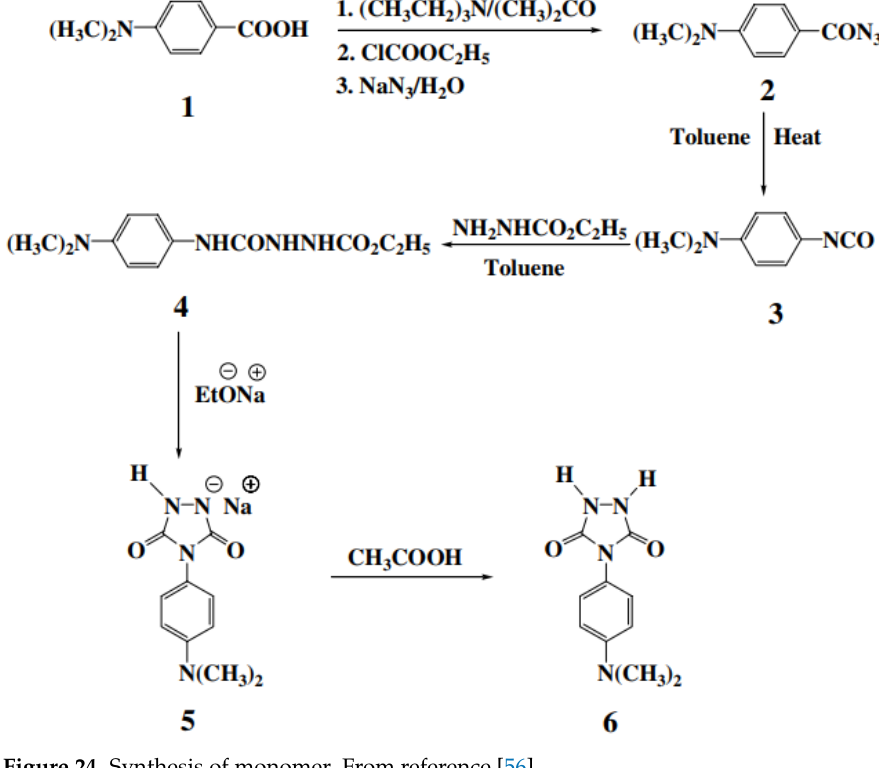
Figure 23. Synthesis of diacids and related diisocyanate monomers. From reference [55].